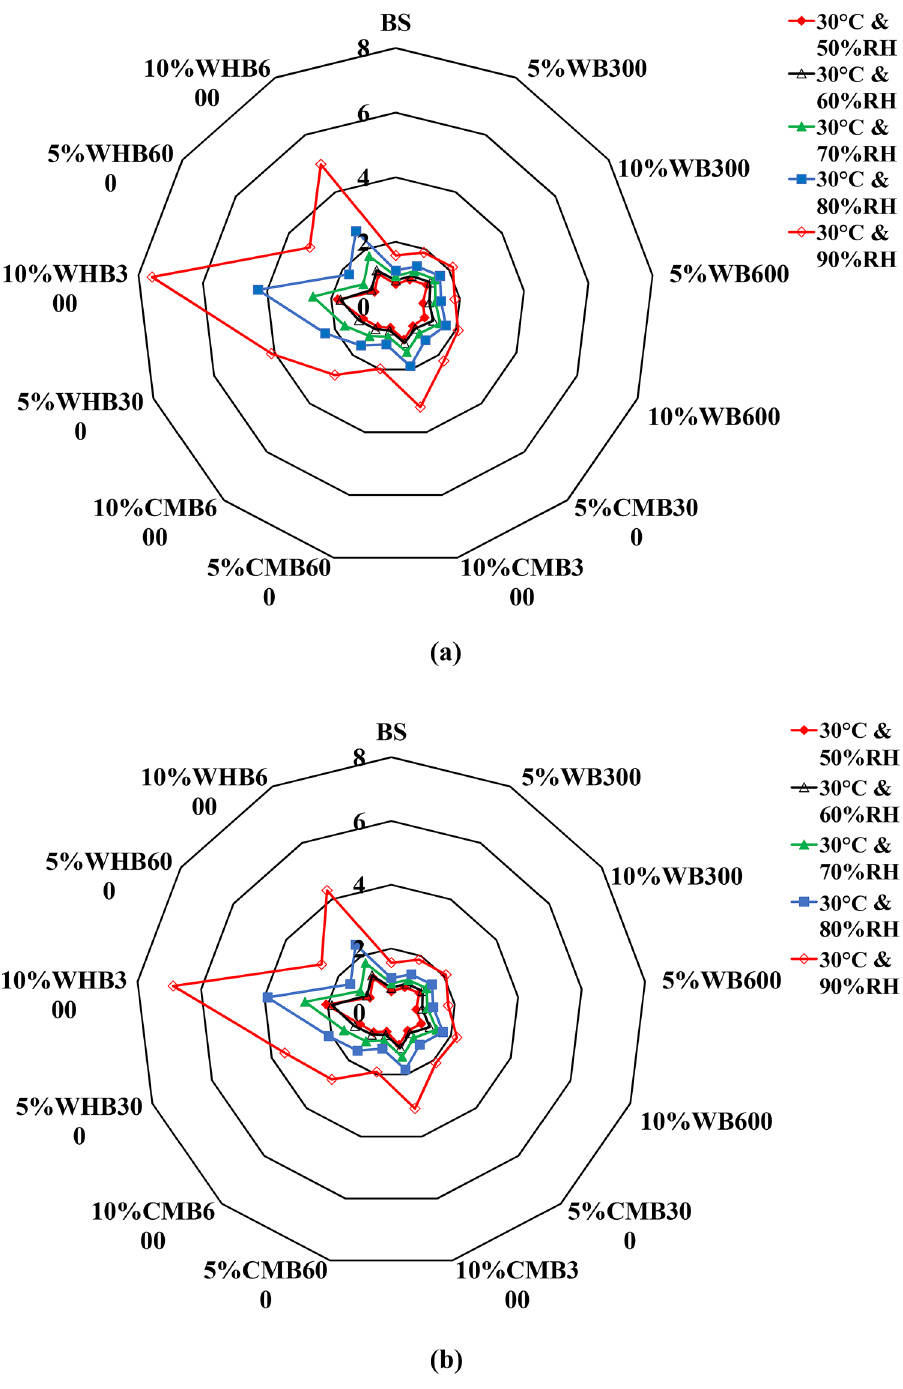
Figure 8. Maximum water content of ( a ) loose samples and ( b ) dense samples various relative humidity conditions under 30 °C temperature